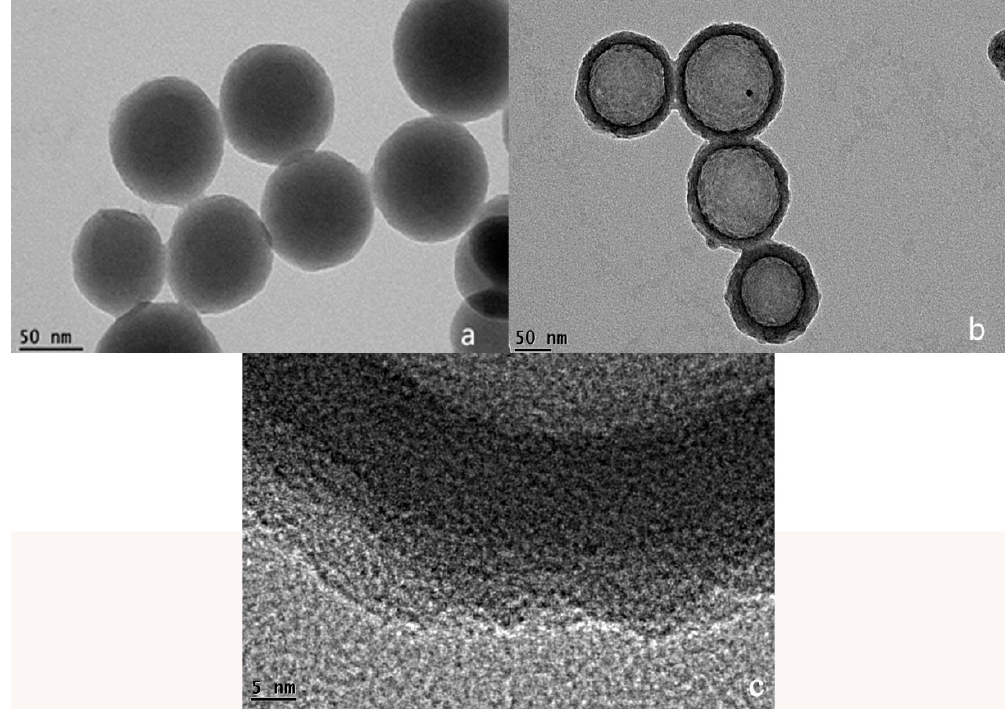
Figure 2. TEM of FITC–SiO 2 ( a ), RFN ( b ), and high resolution transmission electron microscopy (HRTEM) image of the outer surface of the RFN ( c ).